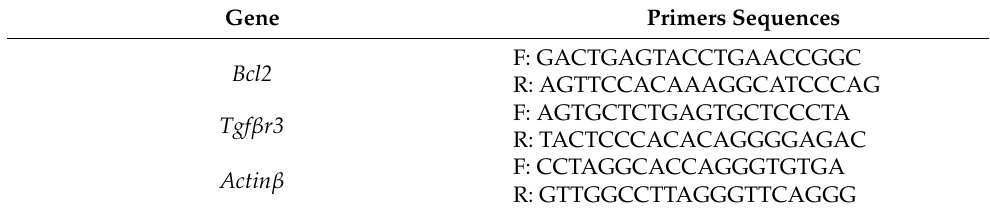
Table 4. List of primers sequences used to detect gene